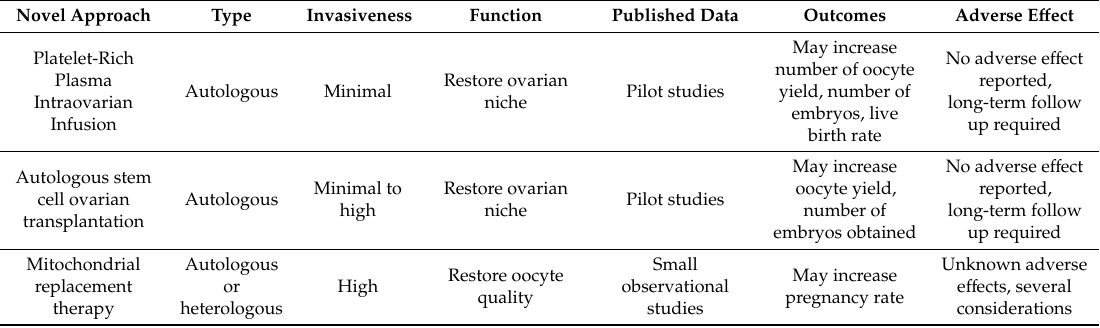
Table 2. Data regarding novel strategies that have been suggested for addressing poor ovarian